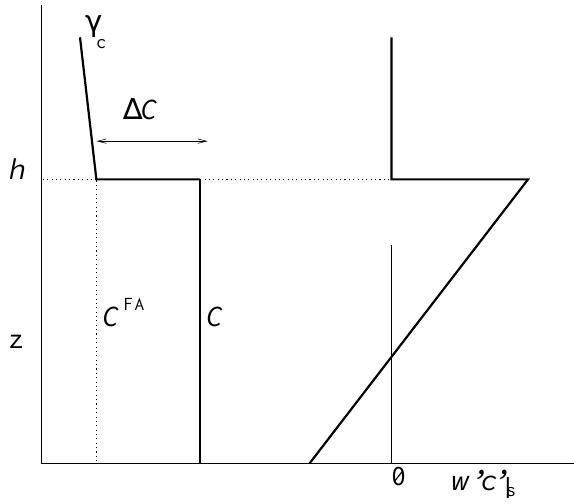
Fig.10. Schematicrepresentations of theverticalprofilesof (left)the CO 2 mixing ratioand (right)theCO 2 fluxofa convective boundary Fig. 10. Schematic representations of the vertical profiles of (left) layerastheonestudiedhereinazeroth-orderjumpmixedlayermodel. the CO 2 mixing ratio and (right) the CO 2 flux of a convective boundary layer as the one studied here in a zeroth-order jump mixed layer